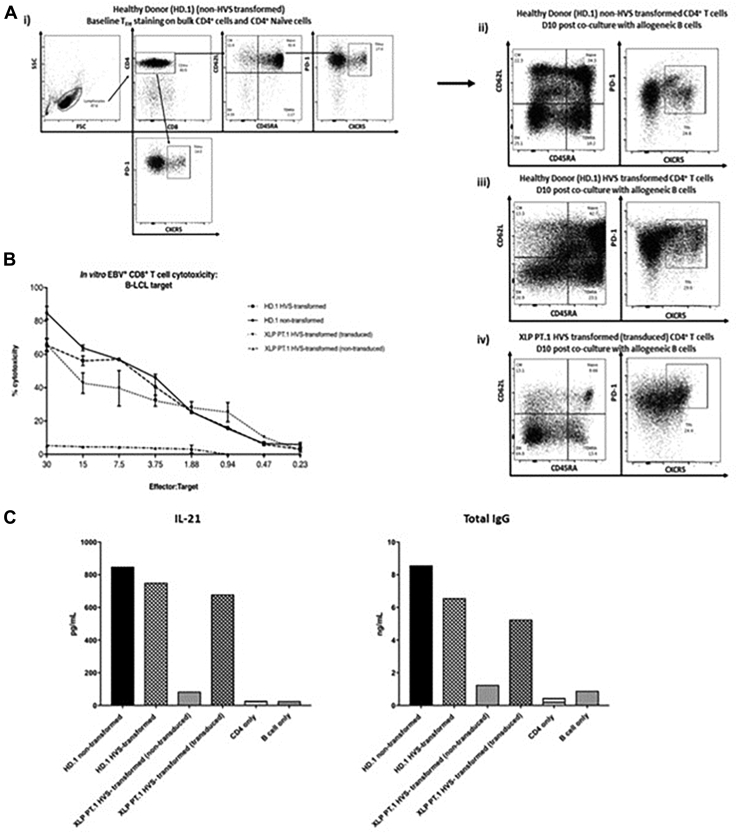
Comparison of function between HVS-transformed cells and untransformed cells. One experiment was performed comparing phenotype (A), cytotoxicity (B), and TFH cell function (C) in HVS-transformed cells from healthy donors, HVS-transformed cells from patients, and nontransformed healthy donor cells, which demonstrated comparability among the all samples. No significant differences were observed in both cytotoxicity and TFH cells assays.